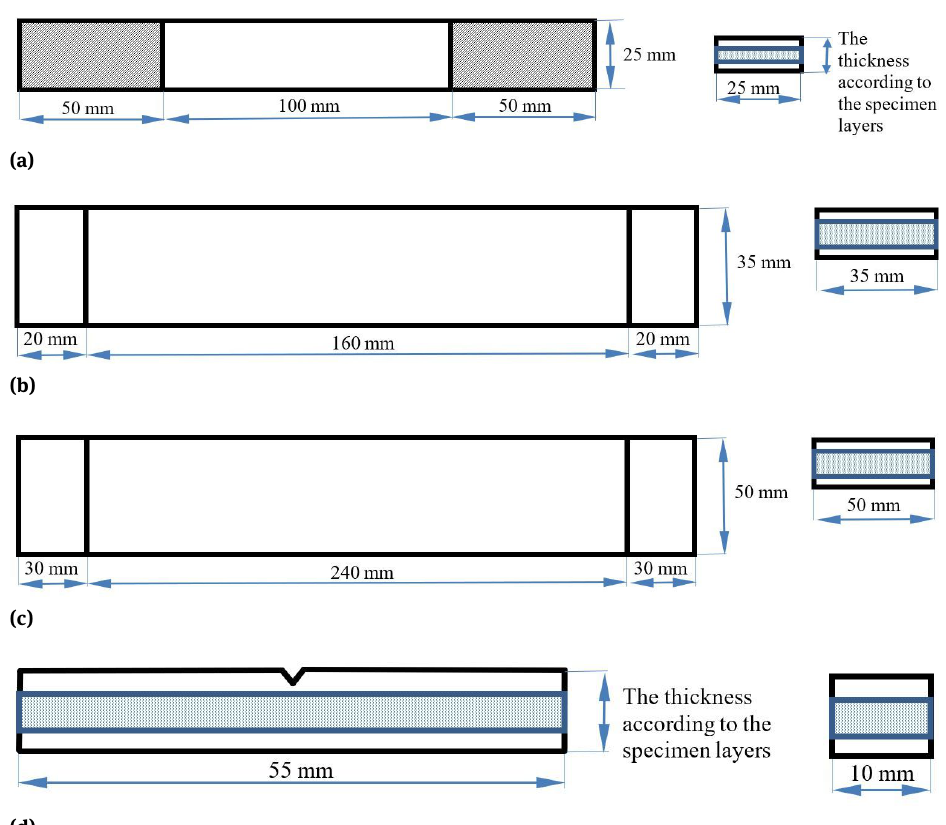
Figure 3: Dimensions of the test specimen according to the test standard: (a) Tensile test – ASTM D3039; (b) Bending test for 5 layers- ASTMD790-03; (c) Bending test for 9 Layer-ASTM D790-03; (d) Impact test/Impact-ASTM D5942-96